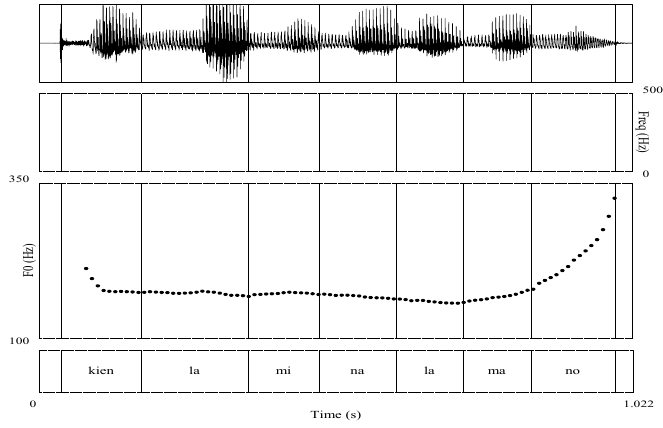
Figure 7. Waveform, spectrogram, and F0 (final rise, penultimate syllable) contour for ¿Quién lamina la mano? (Who laminates the hand?). F0 contour divided according to syllable structure.